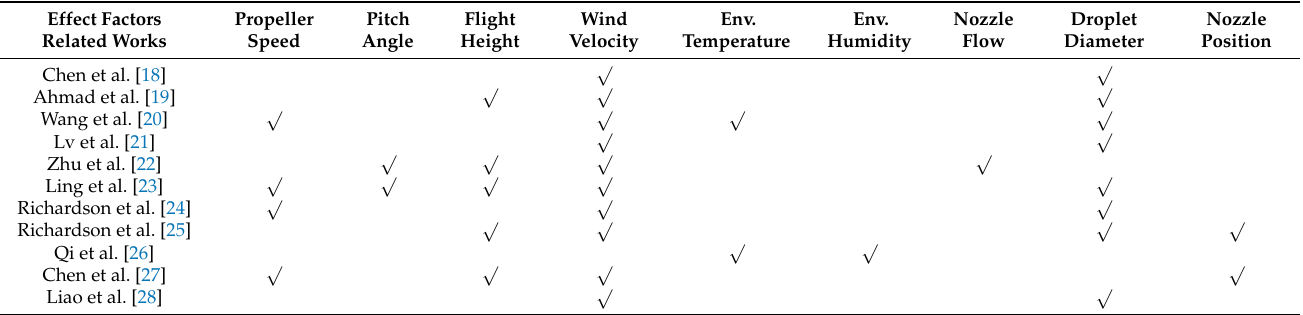
Table 1. Related work on the effect factors of spray droplet